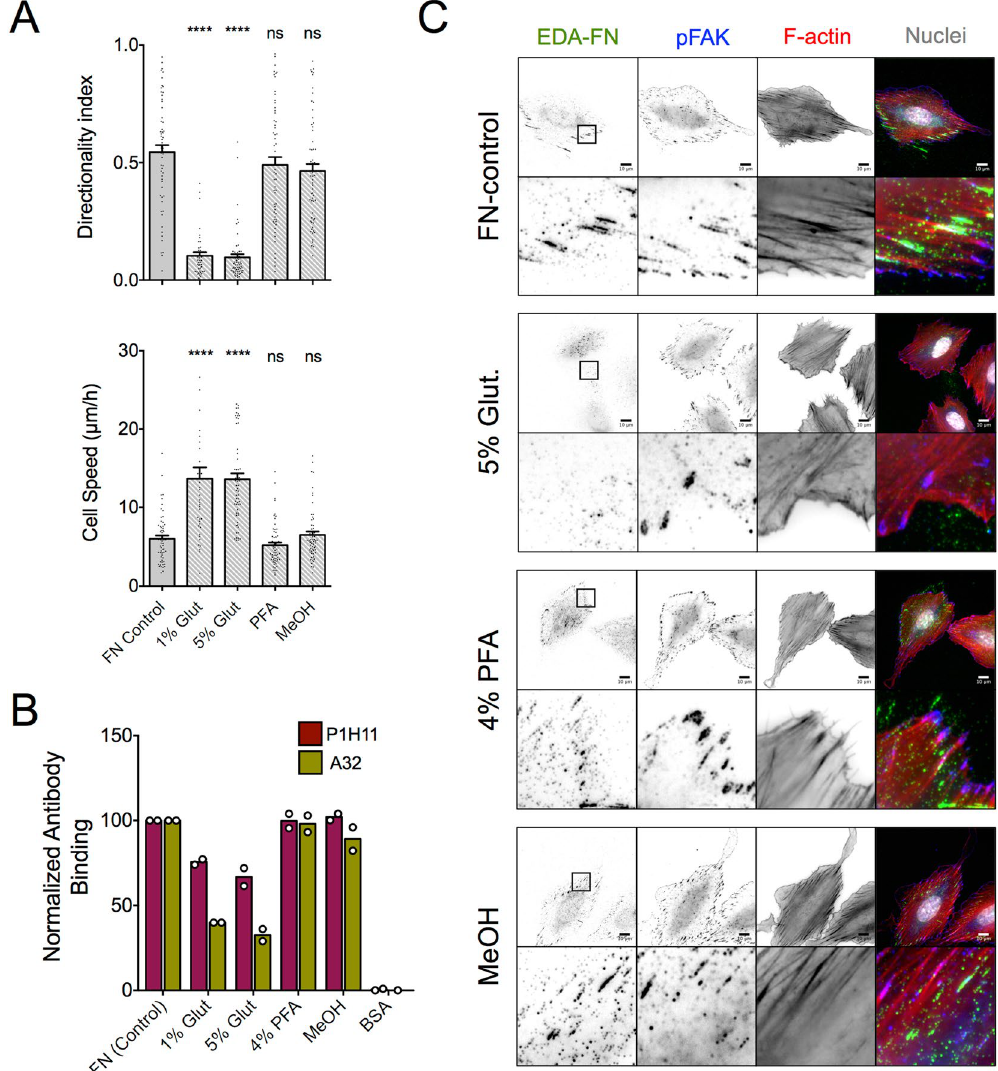
Figure 6. REF motility dependence upon FN treatment with different fixation agents correlates with induced changes in ligand accessibility. ( A ) REF speed and directionality index on FN-coated substrates (10 μ g/ml) treated with different fixation agents. Cell speed and directional persistence were affected by glutaraldehyde (Glut), but not PFA or MeOH treatment of FN prior to cell seeding. Values from treated samples were compared to the control condition using one-way ANOVA analysis (N exp = 2; n = 40 cells for 1% Glut, N exp = 3, n = 60 cells for other samples). Mean ± s.e.m. are presented. ns: not significant, **** P < 0.0001. ( B ) Quantification of antibody binding to FN-coated (control) or FN-treated substrates using a modified ELISA assay. Reduced binding of monoclonal anti-FN antibodies against the CBD (clone P1H11) and the Hep2 domain (clone A32) was observed only for glutaraldehyde-treated samples. Each point represents an independent experiment (n = 5 samples/independent experiment). ( C ) Epifluorescence microscopy images of REF seeded for 6 hours on FN- coated substrates, fixed and stained against indicated proteins. REF were able to form polarized protrusions and assemble cellular FN (EDA-FN) on control, PFA-treated and MeOH-treated substrates, but not glutaraldehyde- treated